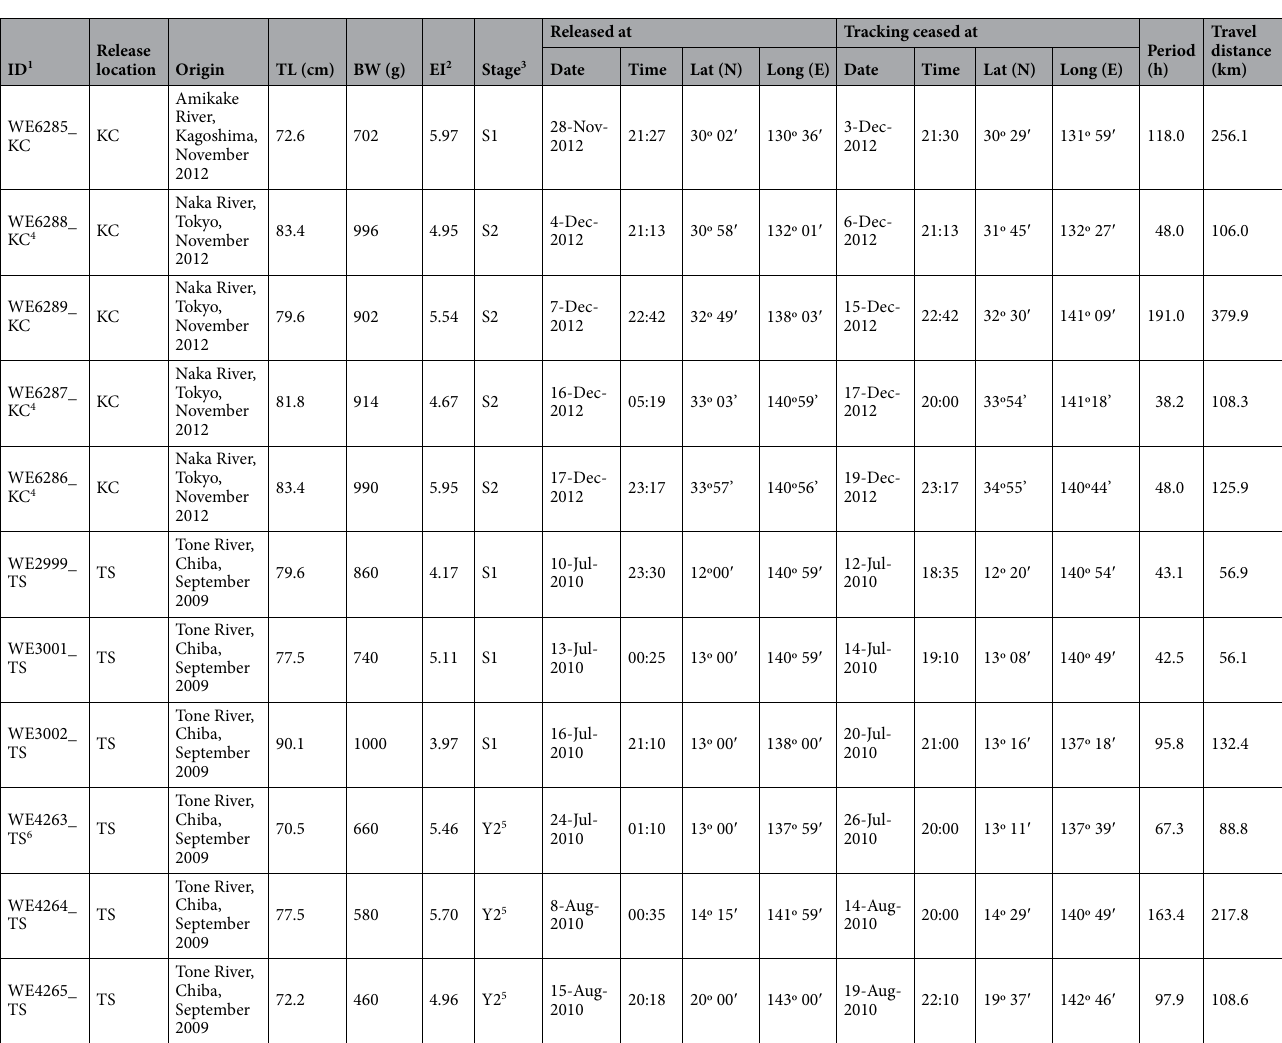
Table 1. Summary of tracking experiments for 11 Japanese eels ( Anguilla japonica ). KC: Kuroshio Current area, TS: Tropical-subtropical area. 1 It consists of the ID in the study by Chow et al. 16 plus the release